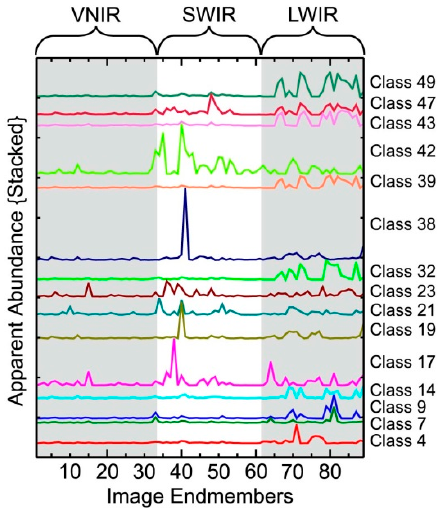
Figure 12. Mean endmember apparent abundance values for selected classes produced by integration of the visible to near infrared (VNIR), shortwave infrared (SWIR), and longwave infrared (LWIR) image endmembers.